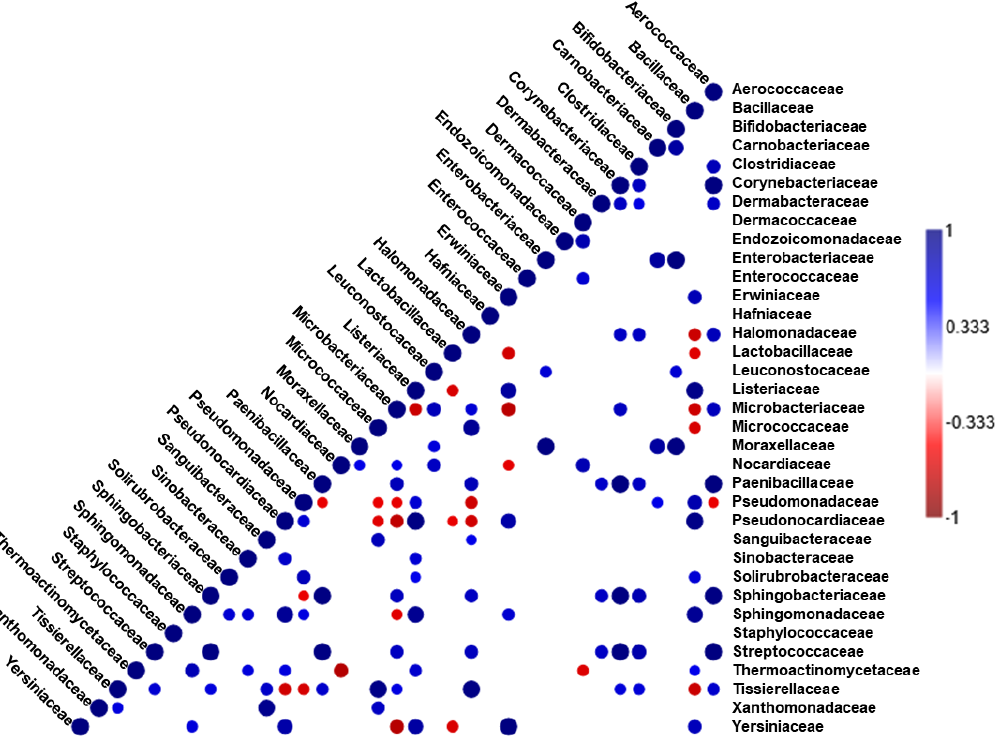
Figure 5. Correlogram representing the matrices of Pearson’s correlation coefficient (r) for different bacterial taxa (at family level) in soy paste samples ( n = 12) prepared by adding Peppermint, Korean mint, and Coriander, relative to those for the control. Only significant ( p < 0.05) positive (blue) and negative (red) correlations are shown in the graph.